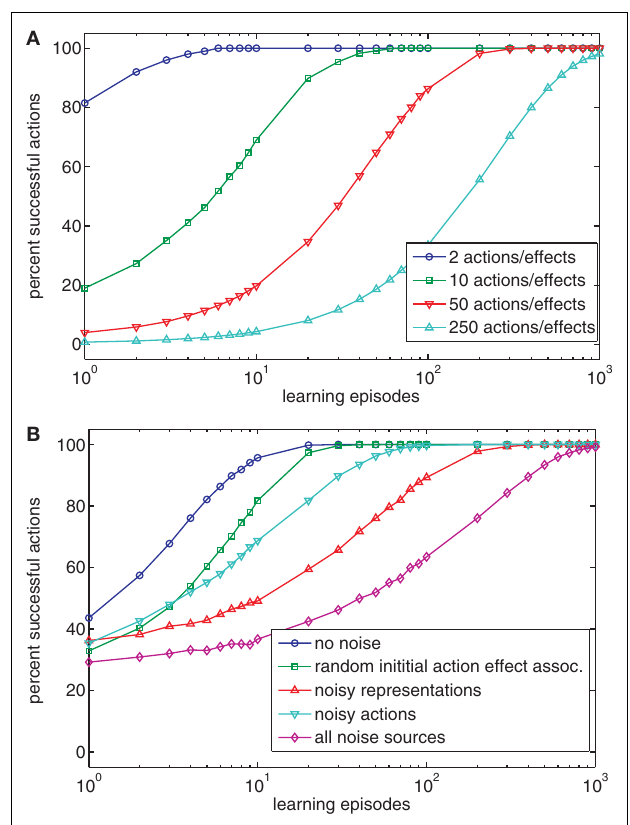
FIGURE 2 | (A) The chart shows the percentage of successful actions after various numbers of learning episodes for scenarios with different numbers of possible actions and effects. (B) The chart shows the impact of various kinds of noise on the performance of the model of IdeomotorTheory (using four